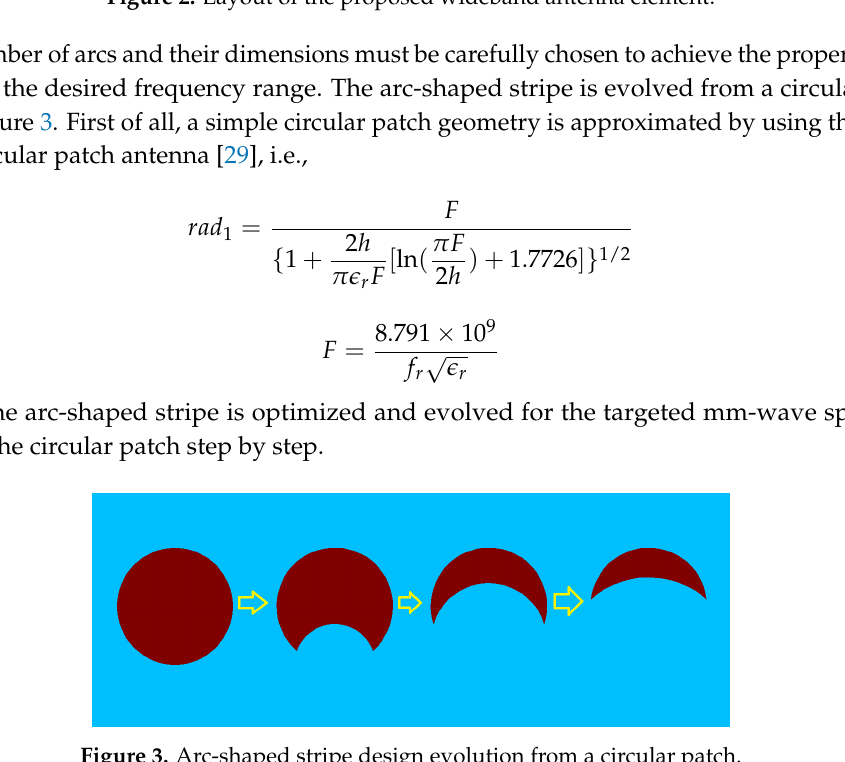
Figure 2. Layout of the proposed wideband antenna element.